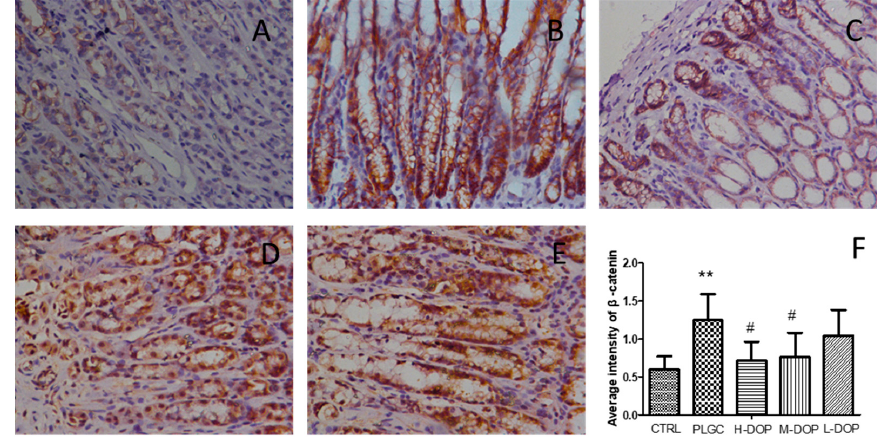
Figure Figure 1. The protein expression of β -catenin in stomach tissues by immunohistochemistry (400 × original magnification). A : The CTRL group: the normal rat were administered with free water and